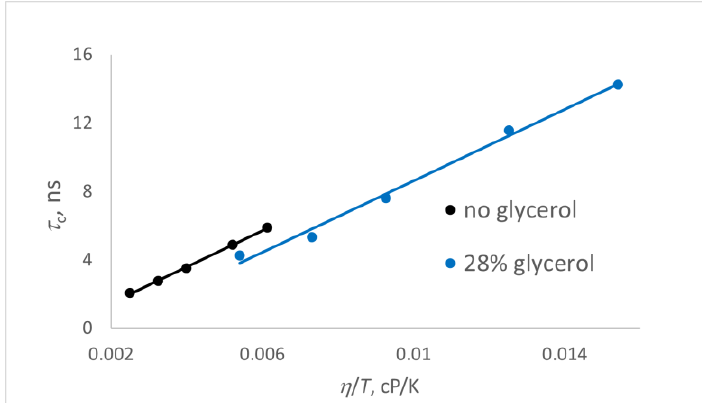
Figure 6. Tumbling times τ C in the perdeuterated and homogeneously 15 N-labeled HP36 protein derived from average 15 N R 1 ρ / R 1 ratios at individual temperatures as a function of ŋ / T in the absence of glycerol (black) and in the presence of 28% w/w glycerol-d8 content (blue). Lines represent linear fits. The temperatures at which the data were collected are 2, 7, 15, 22, and 32 °C.